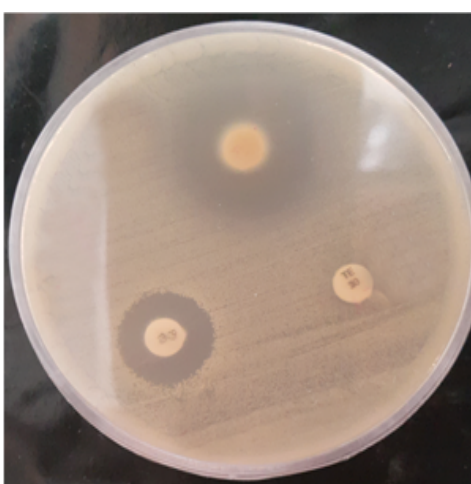
Figure 3. Growth inhibition zone of aqueous of Morus nigra , tetracycline and penicillin on Streptococcus mutans